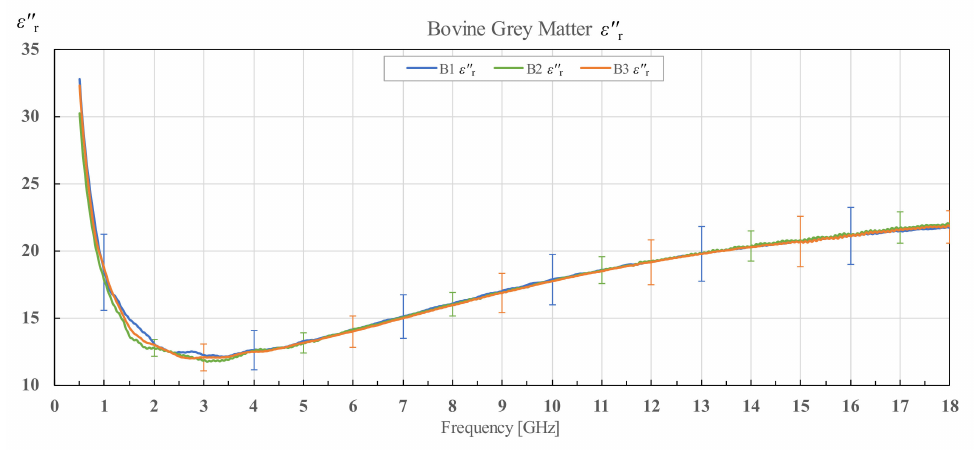
Figure 12. Imaginary part of permittivity of bovine grey matter for brains B1, B2 and B3 with associated standard deviations.